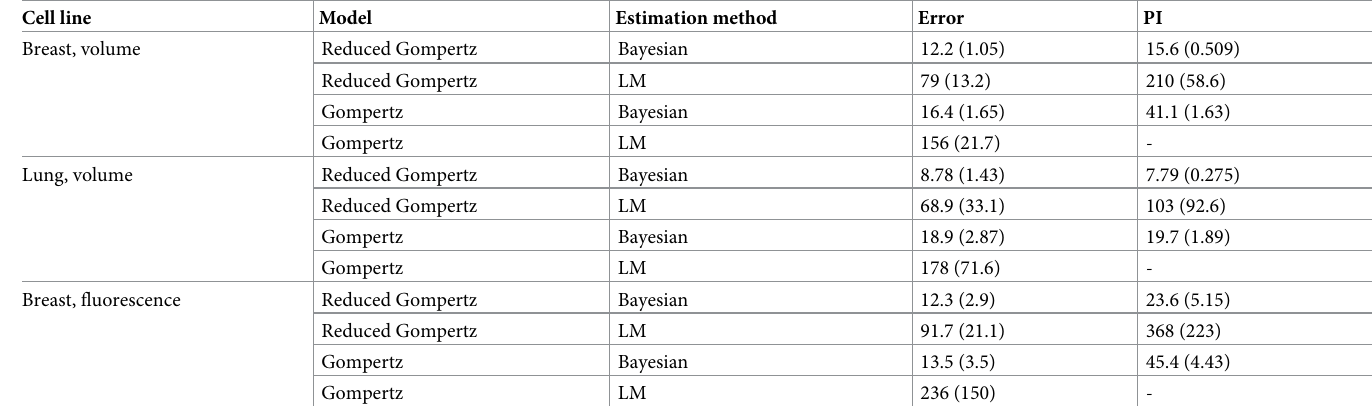
Table 3. Accuracy and precision of methods for prediction of the age of experimental tumors of the three cell lines. Accuracy was defined as the absolute value of the relative error (in percent). Precision was defined as the width of the 95% prediction interval (PI column, in days). Reported are the means and standard errors (in parenthe- sis). LM = likelihood